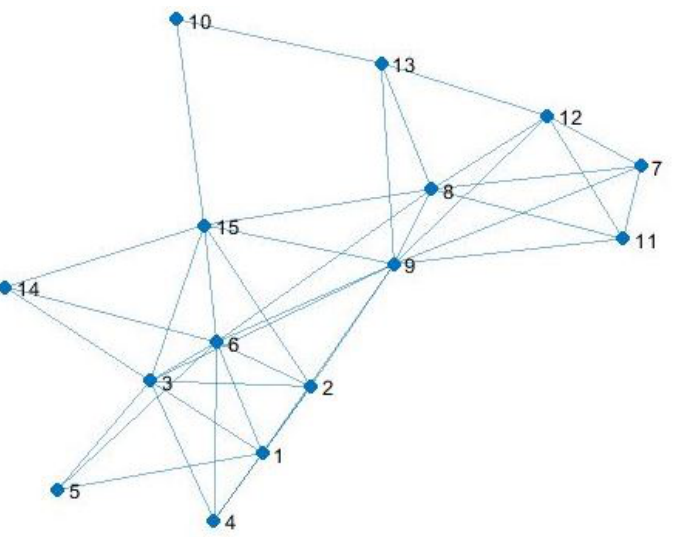
Figure 9. The graph G ( δ ) with δ = 0.65 for N = 15 assets. Vertex number refers to the associated